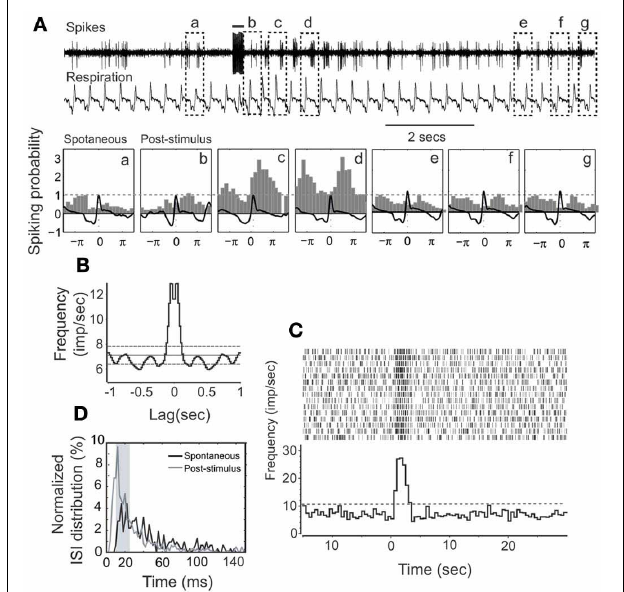
FIGURE 4 | HDB stimulation on a non-synchronized, rhythmically spiking unit. (A) Raw traces show the simultaneous recording of spikes and respiration. This unit has a short-lasting discharging activity. The bar on the top shows the electrical stimulation (100 μ s, 500 μ A, 100Hz, 25 pulses). The respiration triggered spike histograms are shown before (a) or after stimulation (b–g) as described in Figure 3 . (B) An autocorrelation analysis indicates the unit rhythmicity (Bin = 20ms). (C) Histogram and raster plot showing potentiation of spike rates. (D) Plot showing ISI distributions before or after stimulation, respectively. Note that ISIs following NDB stimulation are decreased ( p < 0 .